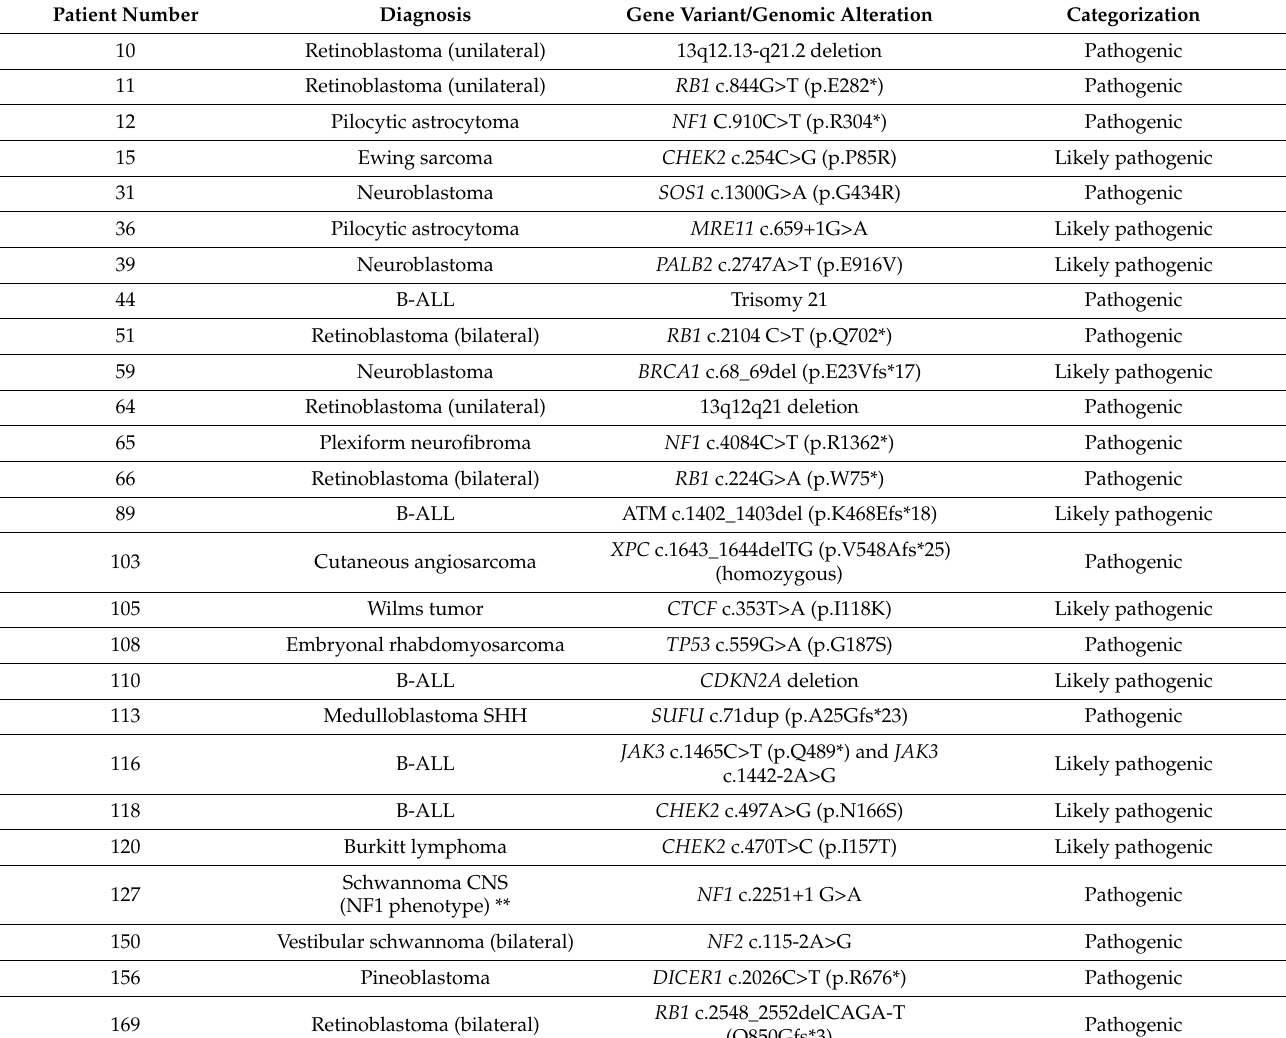
Table 1. Pathogenic or likely pathogenic variants considered to be involved (pathogenic) or maybe involved (likely pathogenic) in patient’s